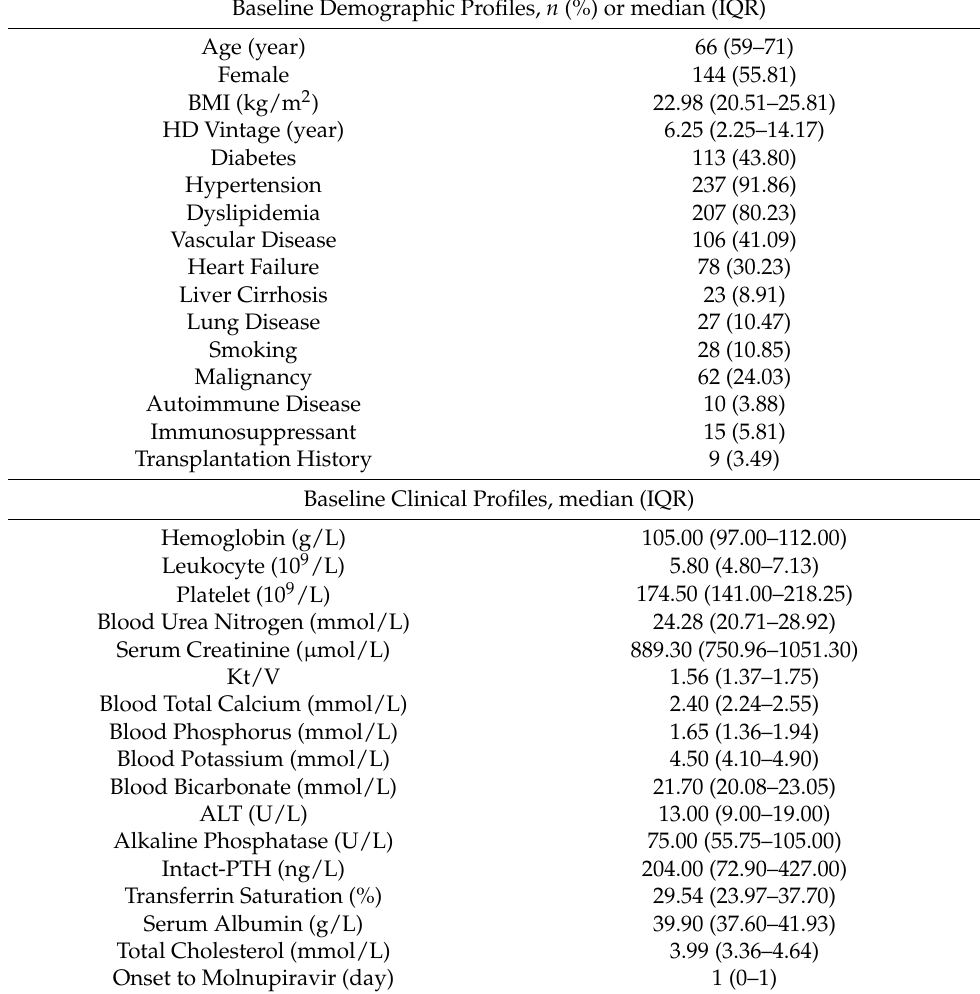
Table 1. Characteristics of HD Patients with COVID-19 Receiving Molnupiravir ( n =